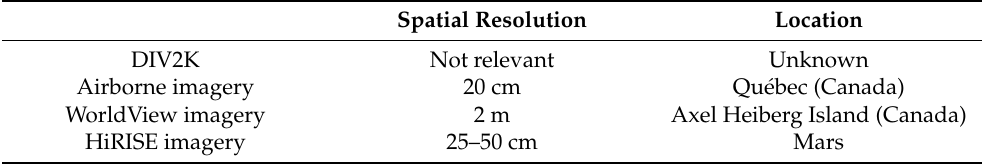
Table 1. Datasets used in this study with their spatial resolution and location when relevant.